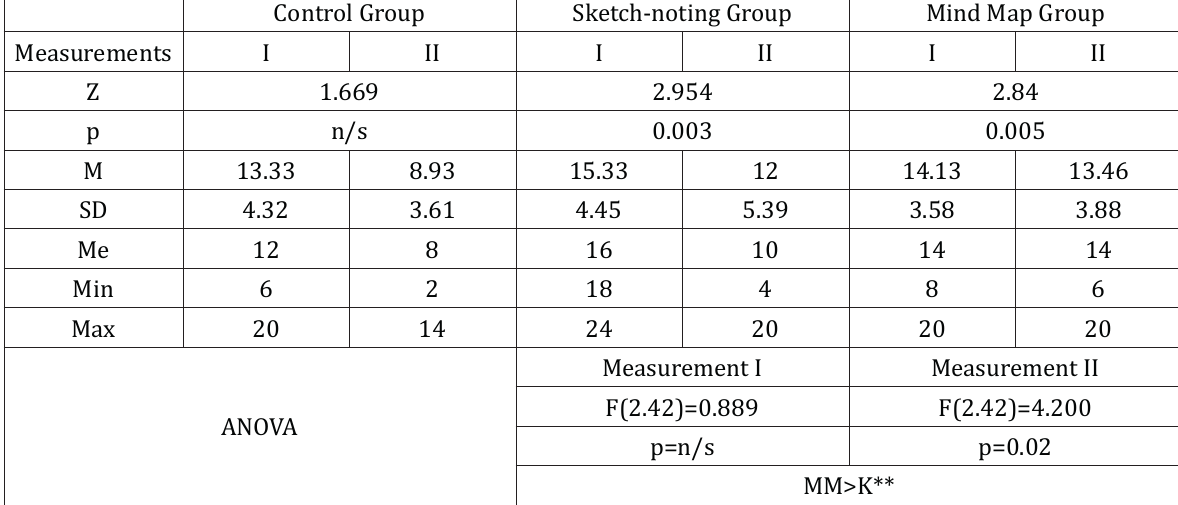
Table 1. Comparison of mean results of the emotional and motivational self-regulation variable (number of errors) in the first and second measurement